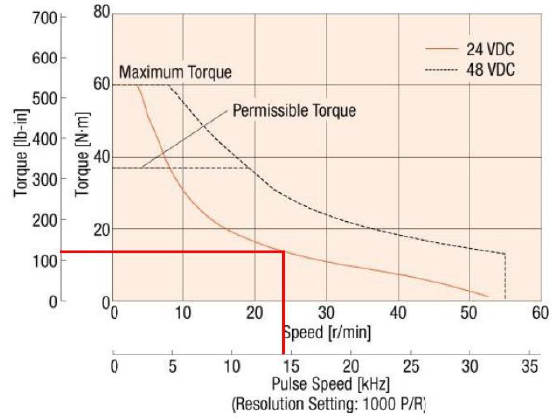
Figure 3. Torque-speed chart for the stepper motor (Oriental Motor U.S.A Corp.), the red line indicates